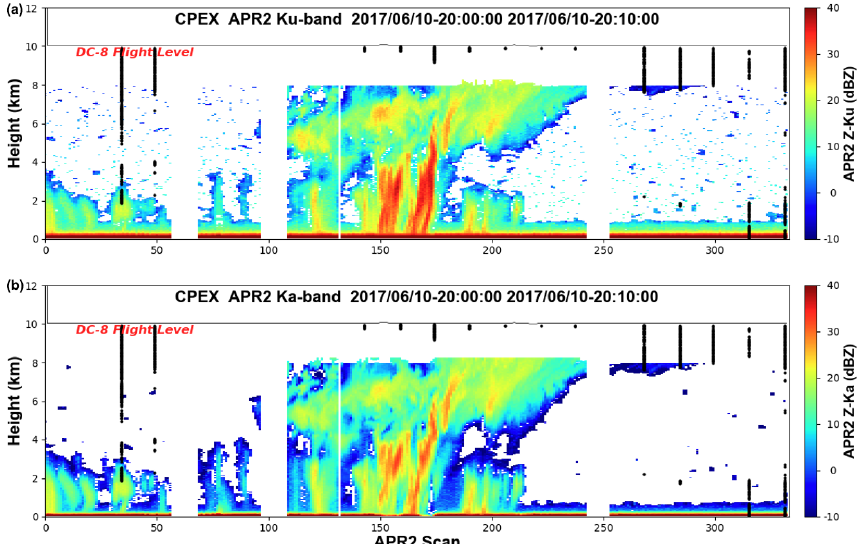
Figure 9. APR-2 measured radar reflectivity vertical profiles for the 10min DC-8 flight period between 20:00–20:10UTC. (a) Ku band. (b) Ka band. The spacing between each APR-2 scan is 360m. The black dots indicate DAWN wind profile